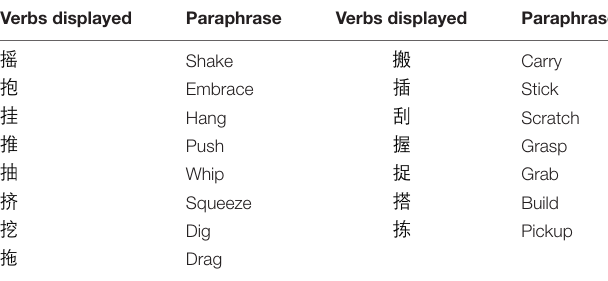
TABLE 2 | Verbs repeated by the participant in Experiment 3. Verbs displayed Paraphrase Verbs displayed